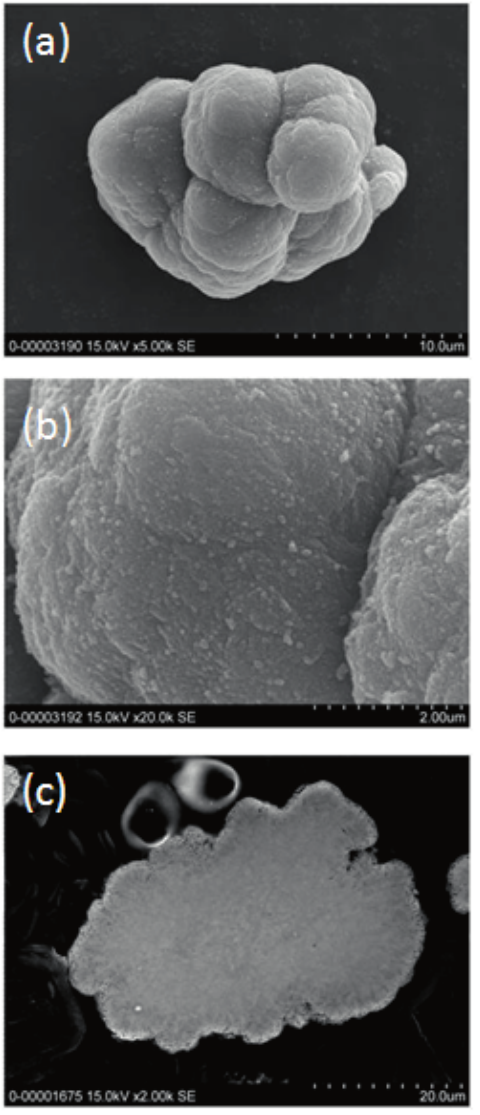
Figure 4. SEM images of solid particles obtained by alka- line treatment, observed at (a) low magnification and (b) high magnification; (c) particles cross-section.